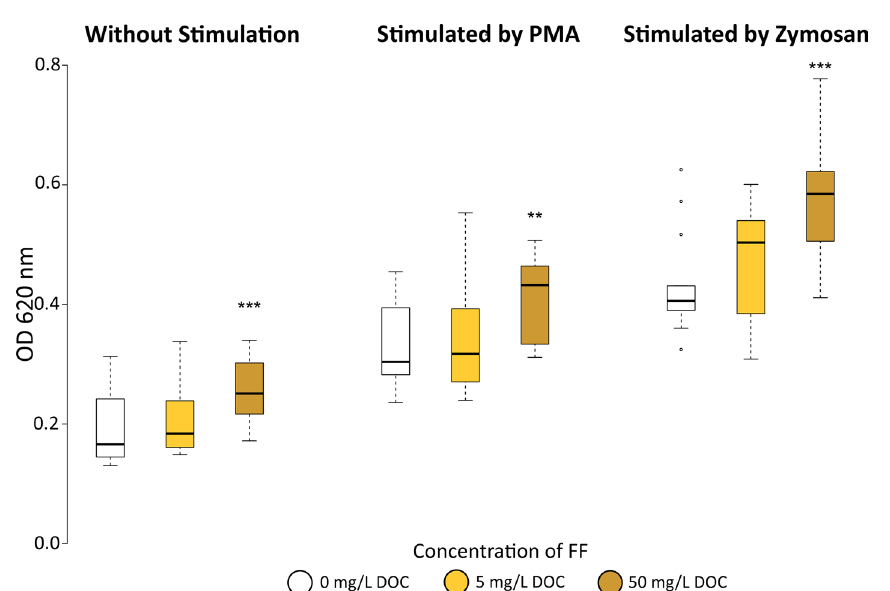
Figure 4. Production of reactive oxygen species of head kidney leucocytes measured by NBT (nitro blue tetrazolium) assay. (A) Without additional stimulation; (B) using PMA (phorbol 12-myristate 13-acetate) as a stimulant; (C) using zymosan as a stimulant. Optical density (OD) was measured at 620 nm. **p < 0.01; ***p < 0.001. n =